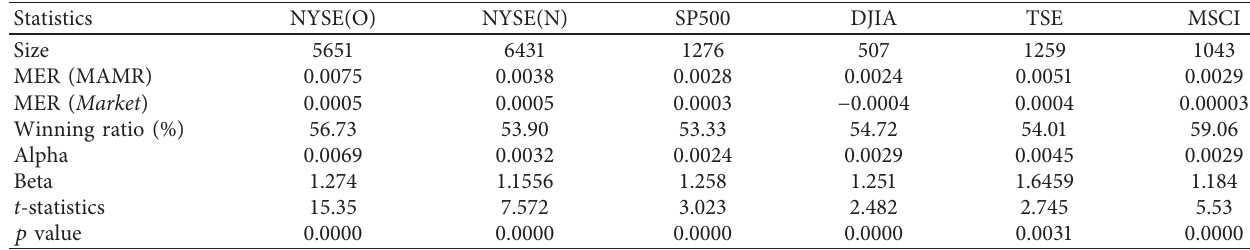
Table 4: Statistical t -test of the performance achieved by